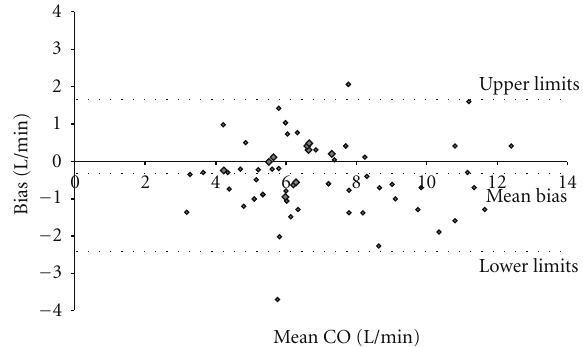
Figure 2: Bland-Altmann plot of left-sided, aortal CO measure- ments by USCOM versus PiCCO. The mean bias was − 0.36 L/min ± 0.99 with 95% limits of agreement from − 2.34 to 1.62. The percentage error according to Critchley and Critchley was